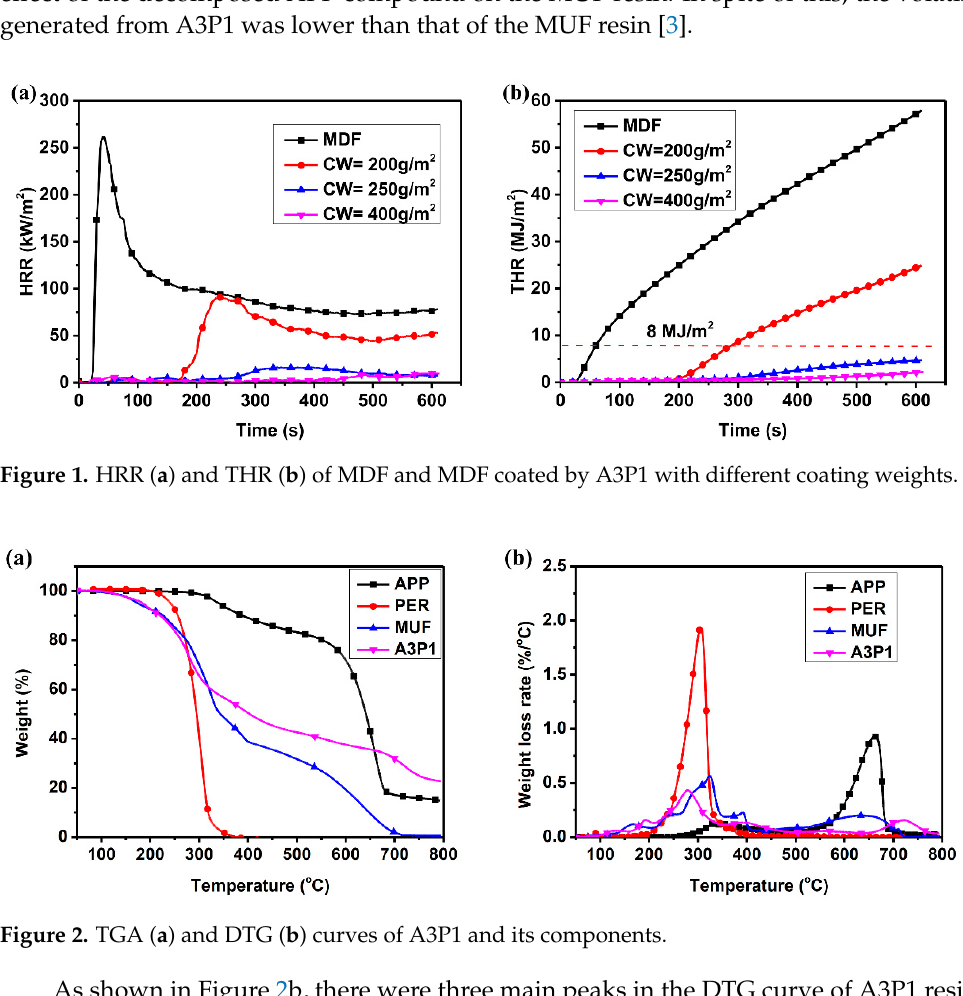
Figure 1. HRR ( a ) and THR ( b ) of MDF and MDF coated by A3P1 with different coating weights.